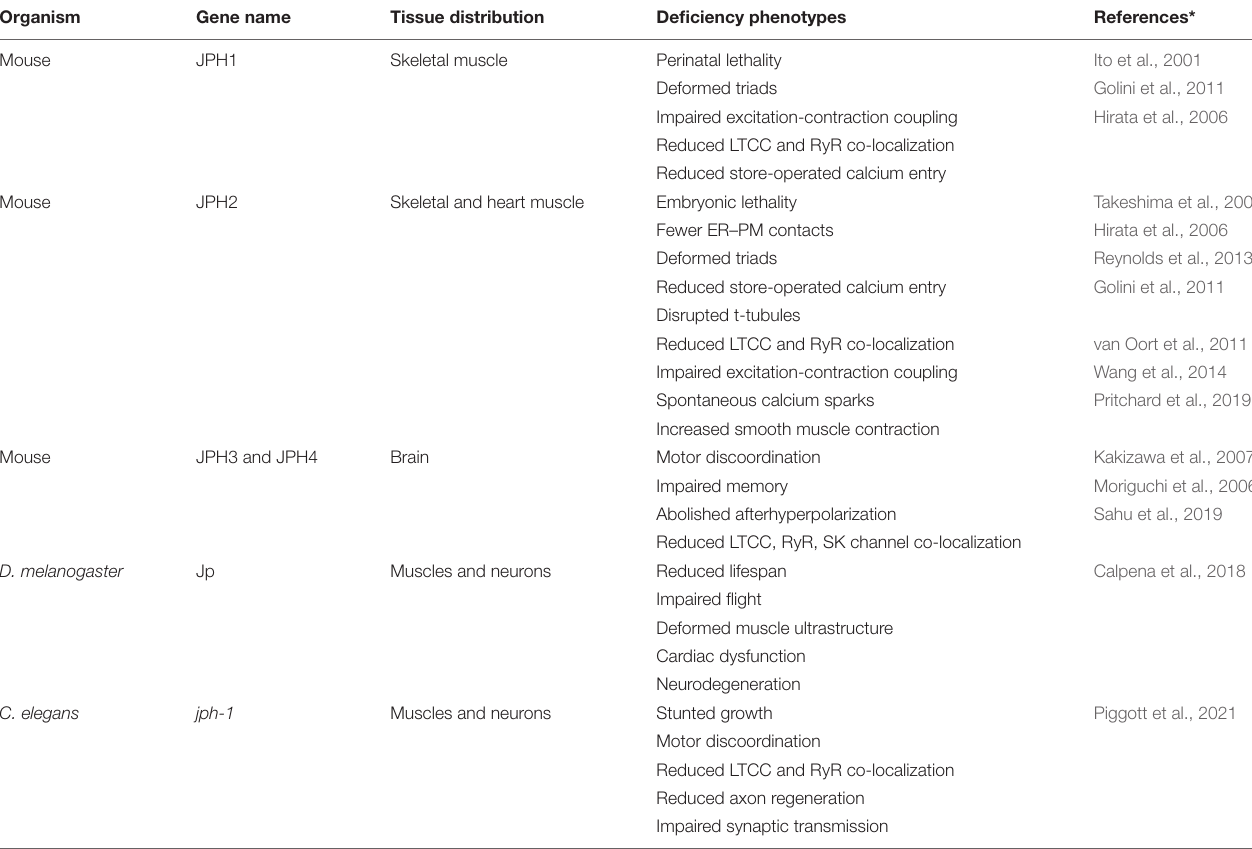
TABLE 1 | Functions of junctophilins from invertebrates to